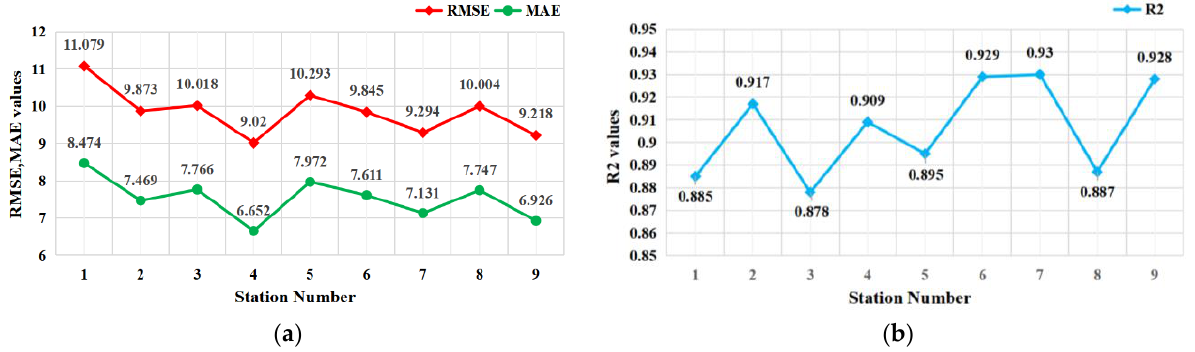
Figure 12. Comparison of predict performance between different stations. The model performance evaluation indexes of different stations include: ( a ) RMSE and MAE , ( b ) R 2 .